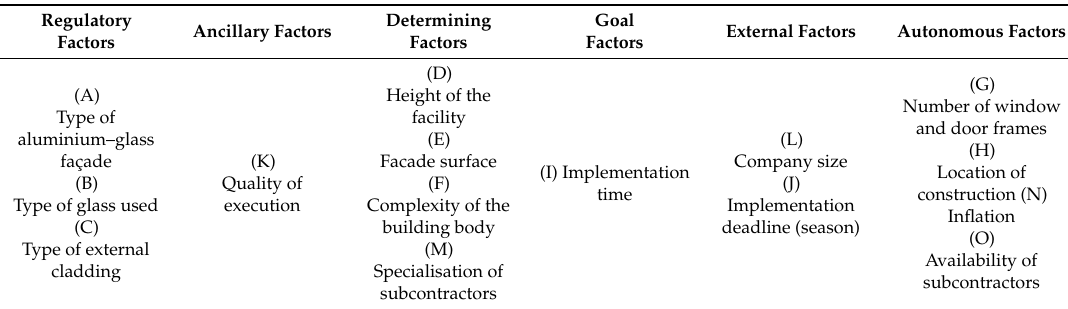
Table 3. Factors per